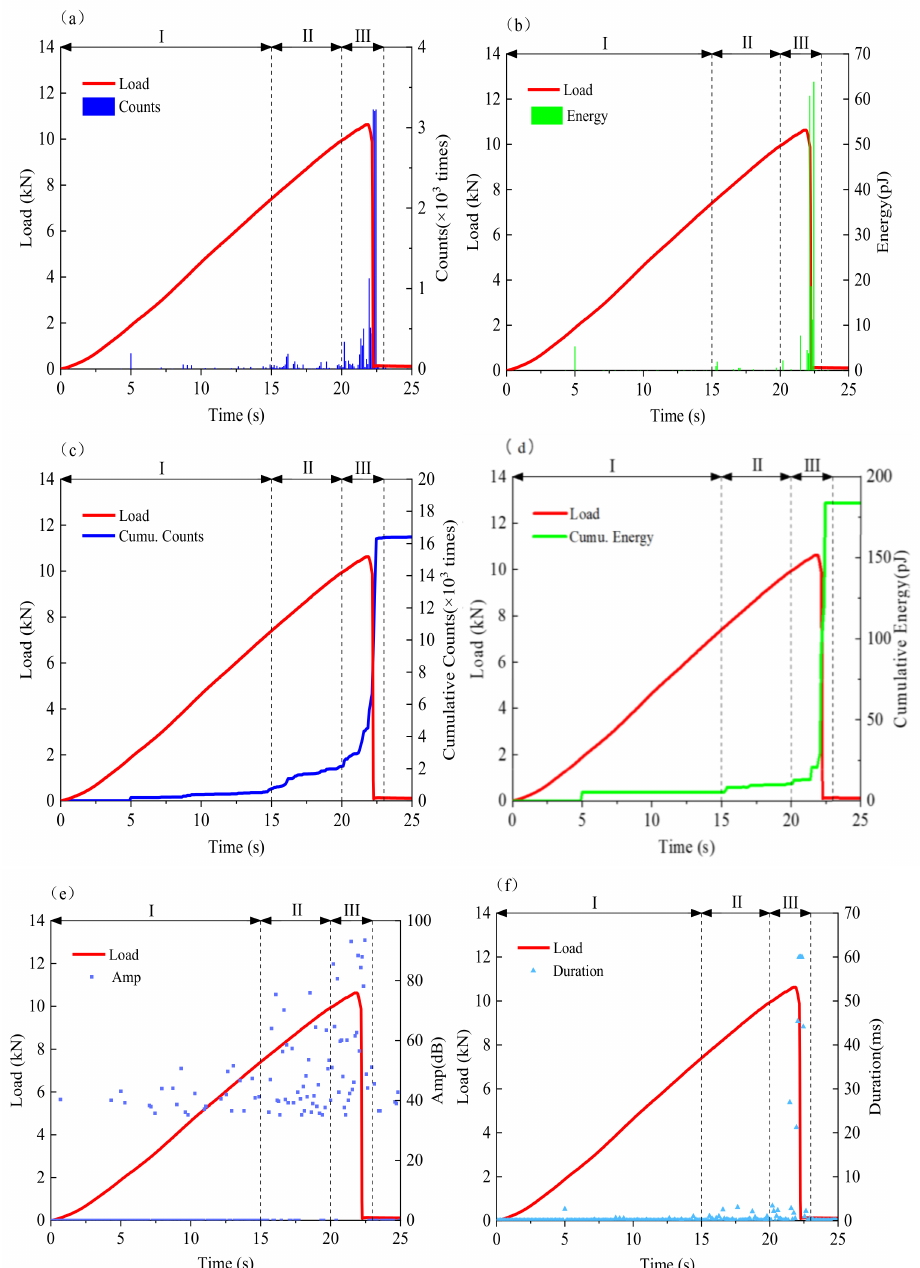
Figure 8. Characteristic AE parameters: ( a ) AE ringing counts; ( b ) AE energy; ( c ) Cumulative ringing counts; ( d ) Cumulative energy; ( e ) Amplitude; ( f )